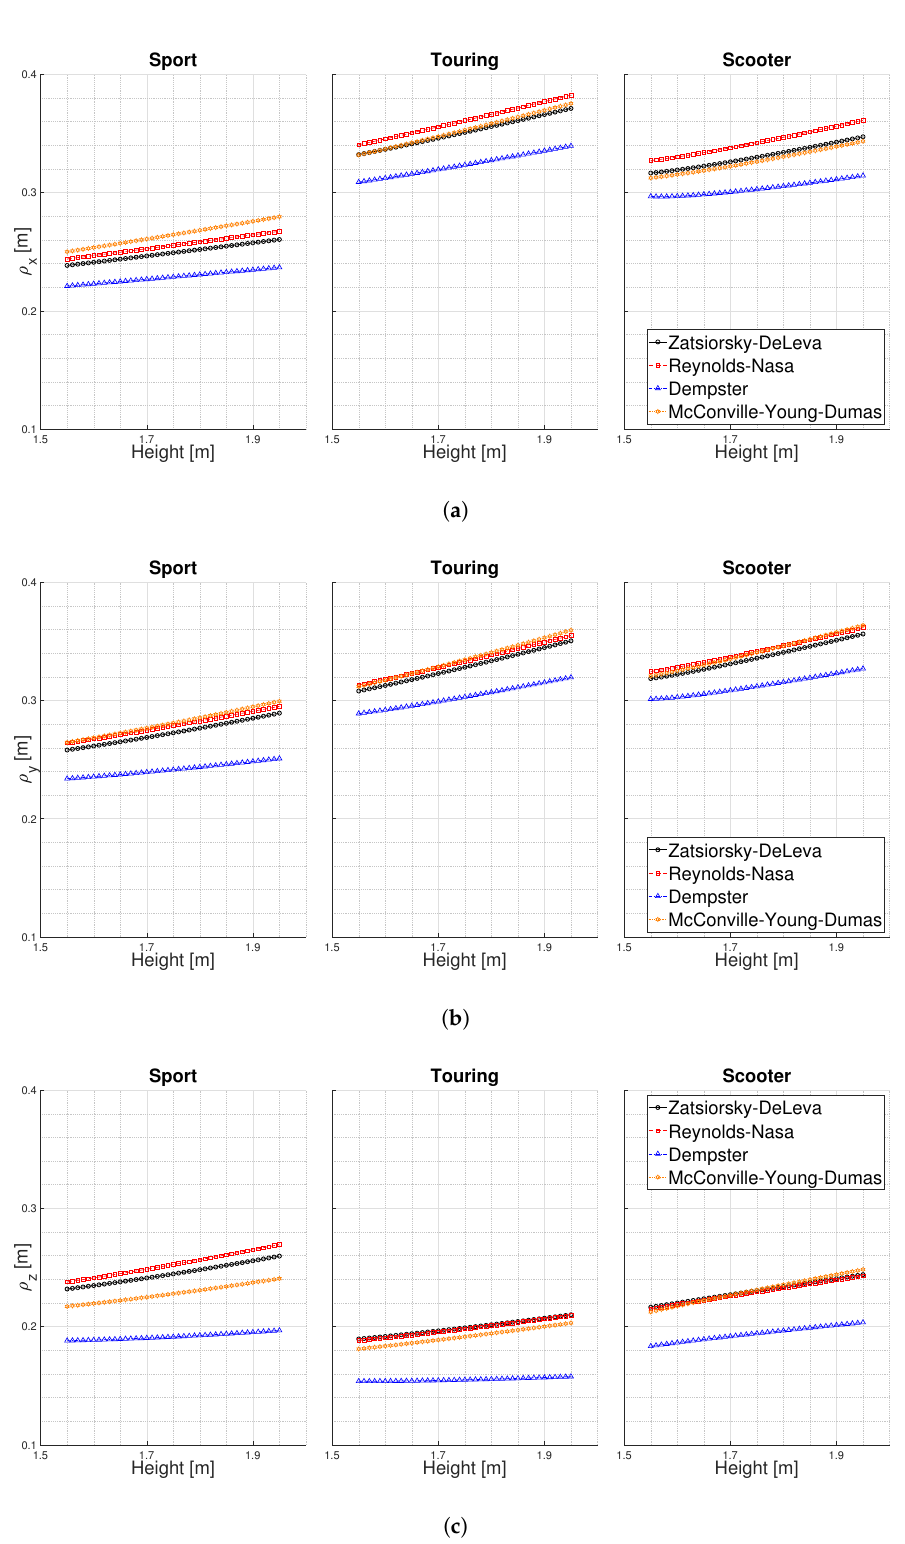
Figure 11. Roll ρ x ( a ), pitch ρ y ( b ), and yaw ρ z ( c ) gyration radii as a function of rider